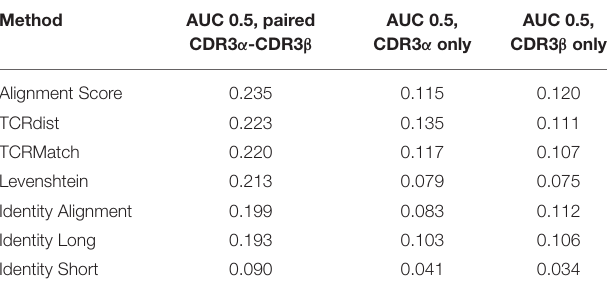
TABLE 2 | AUC 0.5 values by metric from analysis of paired CDR3 α -CDR3 β dataset.